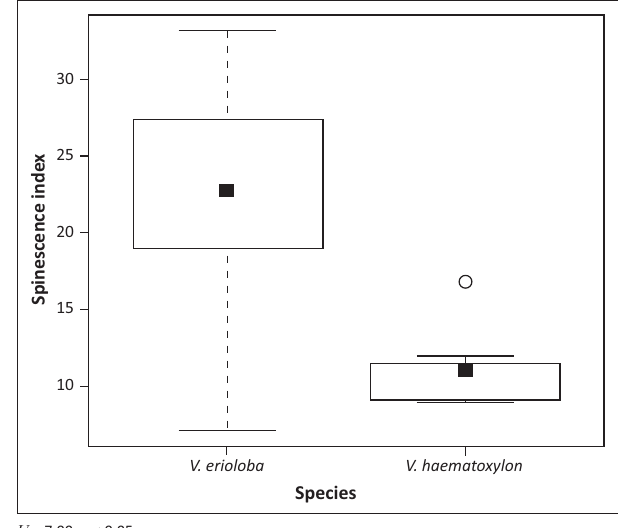
FIGURE 4: Means and interquartile range for our spinescence indices showing that Vachellia erioloba is significantly more spinescent that Vachellia haematoxylon .